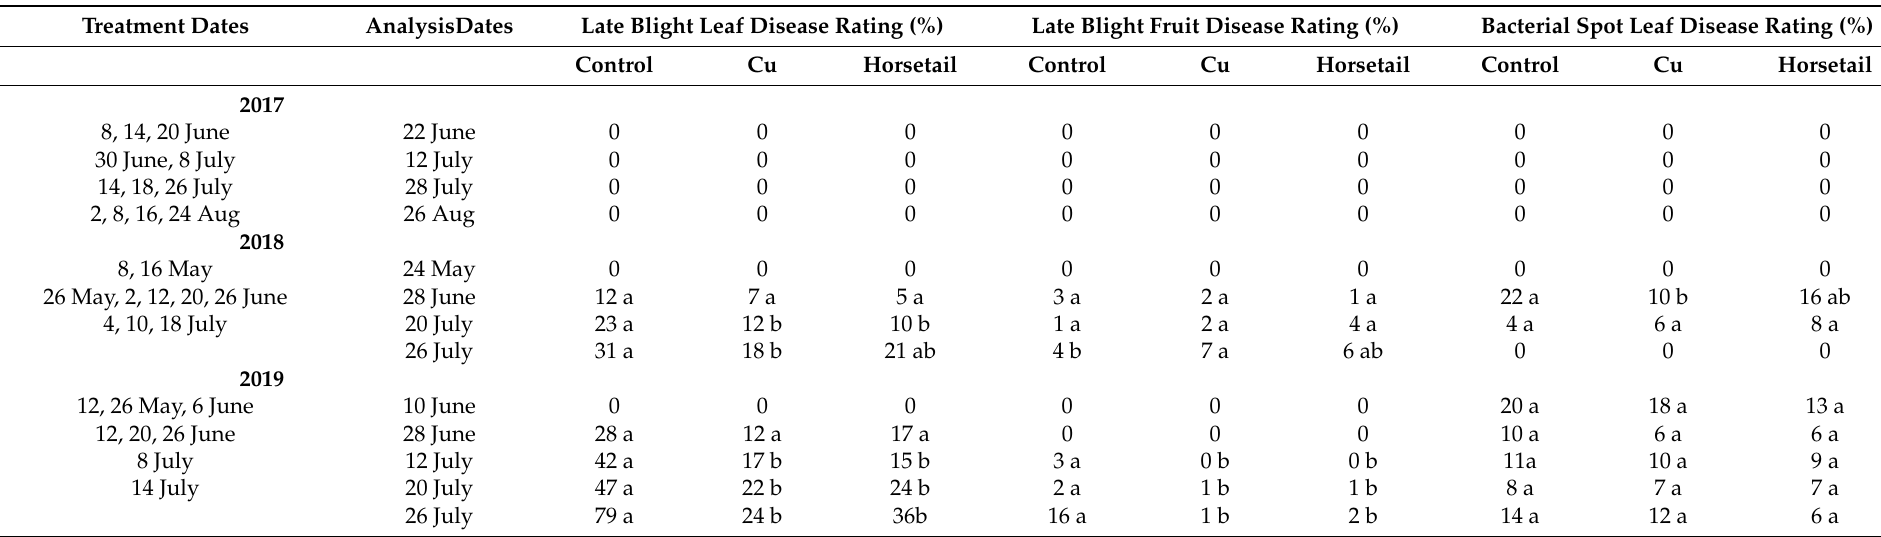
Table 1. Calendar dates for Cu and horsetail macerate treatments and disease ratings for Phytophthora infestans pv. vesicatoria (late blight) and Xanthomonas campestri (bacterial spot) of tomato during routine analyses over a three-year period. Different letters indicate significant differences ( p <